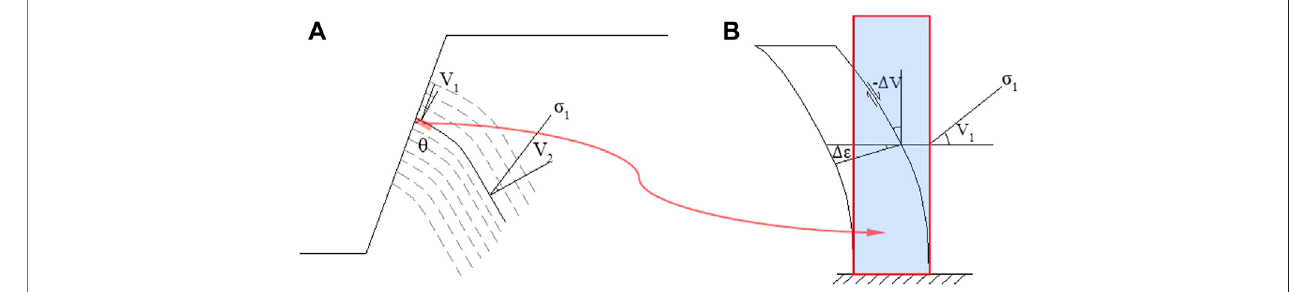
FIGURE 4 | Model for shear creep of bedding surface. (A) Toppling element of shear creep; (B) stress-strain state.